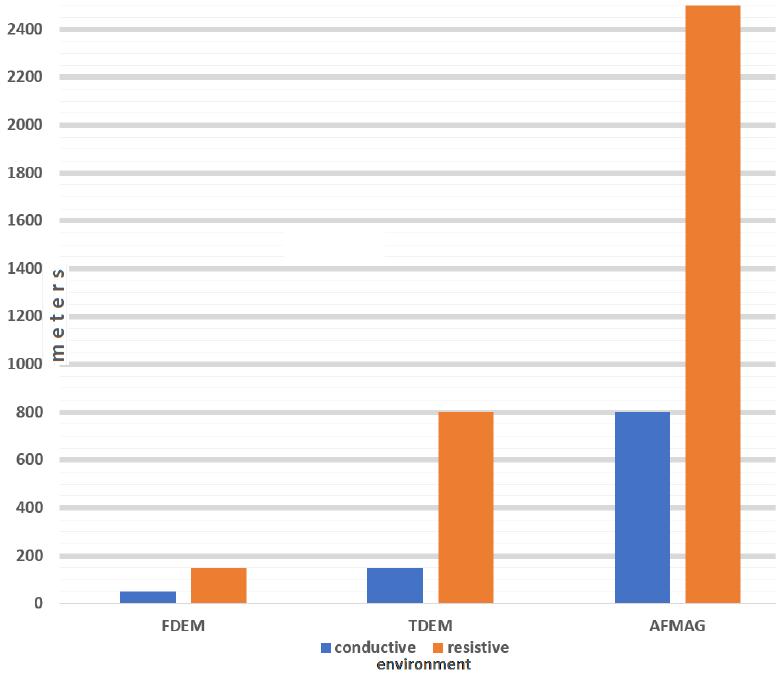
Figure 1. Approximate depth of investigation estimation of different airborne electromagnetic prin- ciples.